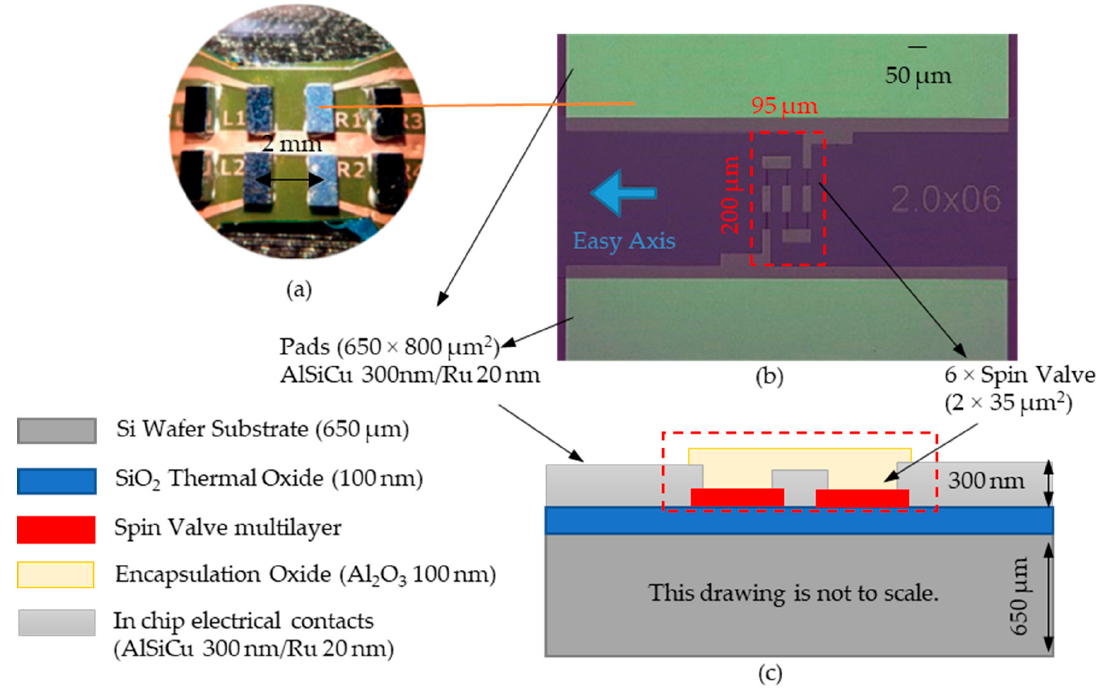
Figure 3. ( a ) Si chips facing down and connected to the FPC. ( b ) Top view of the microfabricated 6 spin valve sensor in series, where each is 2 × 35 µ m 2 . The arrow to the left of the sensor series side indicates the sensitive direction of these. ( c ) Cross-section schematic of the rigid Si chip.